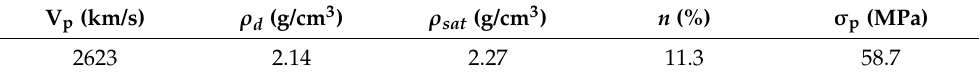
Figure 2. Results of X-ray diffraction test. Table 1. Mean values of physico-mechanical parameters of yellow sandstone.